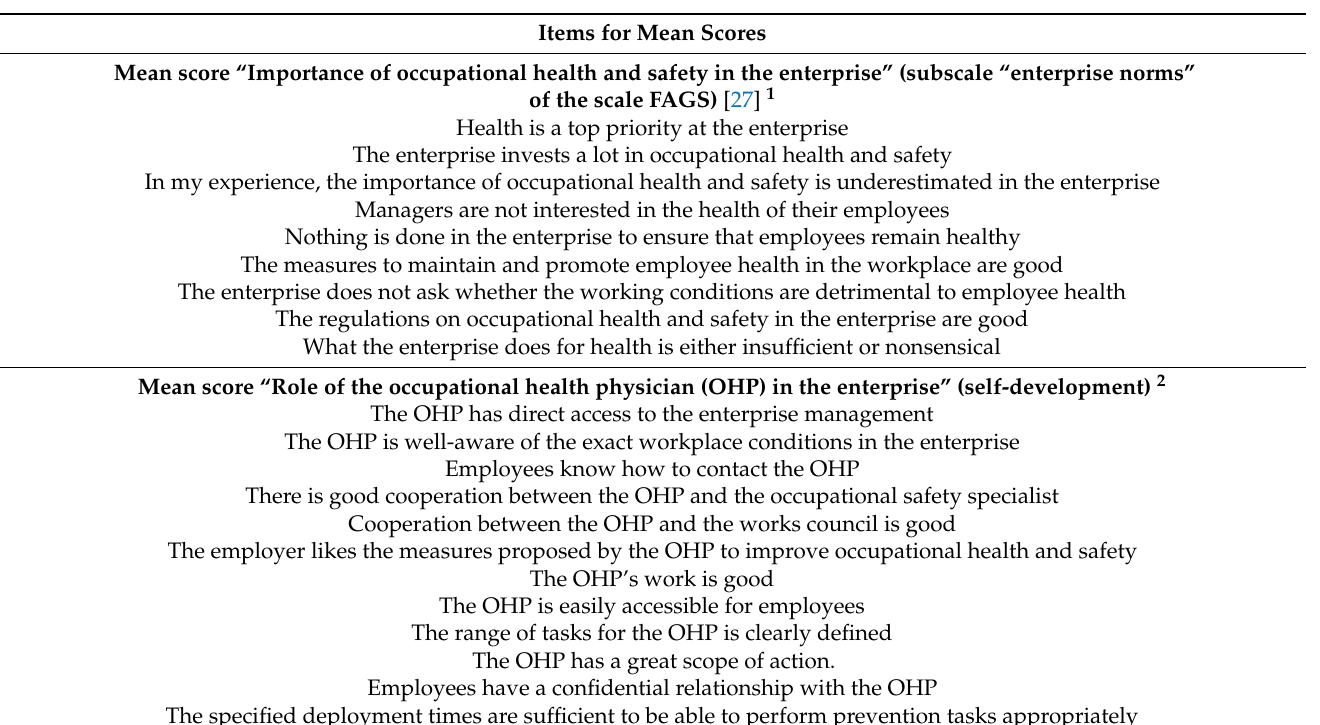
Table A1. Single items for score